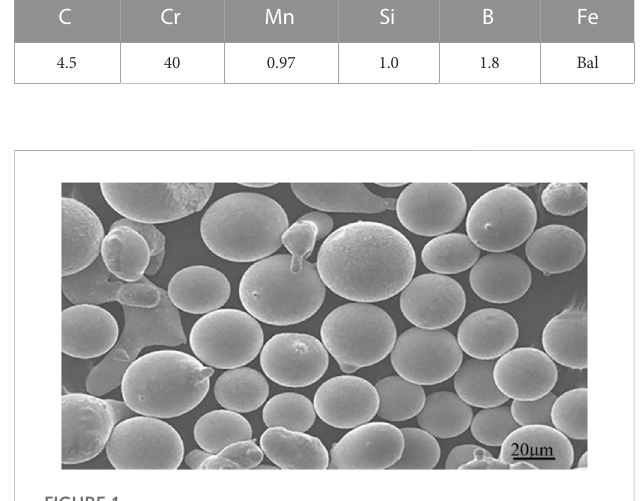
FIGURE 1 SEM morphology of iron-based alloy spherical